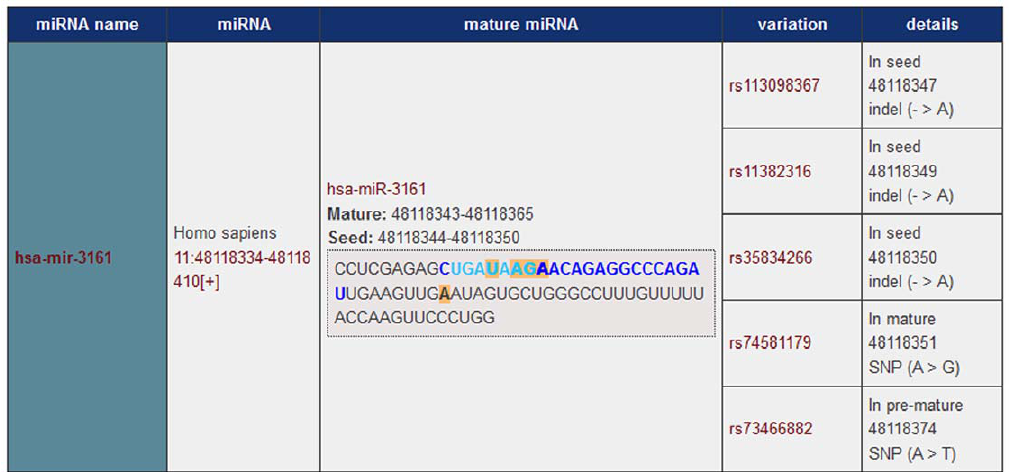
Figure 2. Output of developed miRNA SNiPer tool. An example of miR-SNPs located in pre-miRNA, mature, or seed region of the human miRNA hsa-miR-3161 . Mature miRNA sequence are highlighted in dark blue, seed regions in light blue, and polymorphisms in orange.